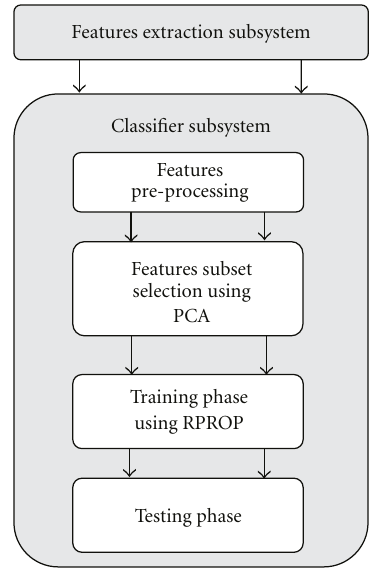
Figure 7: Detailed block diagram of the proposed modulation recognition